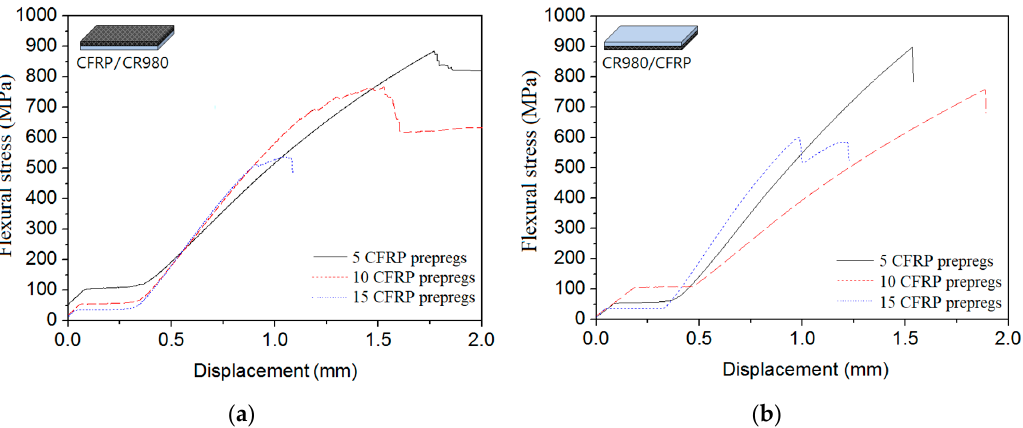
Figure 8. Flexural stress of hybrid composites according to the laminating number of CFRP prepregs: ( a ) CFRP/CR980; ( b ) CR980/CFRP.